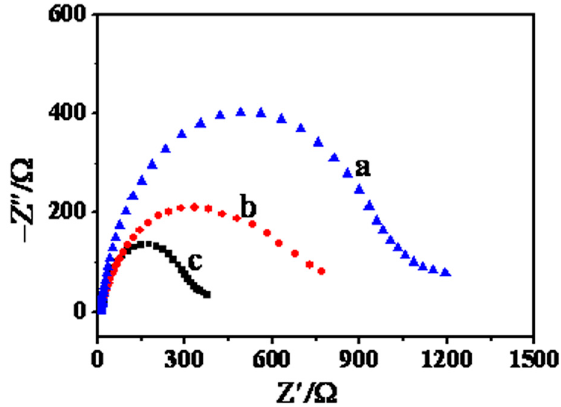
Figure 8. Nyquist plots of Electrochemical Impedance Spectra (EIS) in 0.5 M H 2 SO 4 + 1.0 M CH 3 OH: Pt/C ‐ JM (a), Pt/GNs (b), and Pt ‐ Ag/GNs (c).